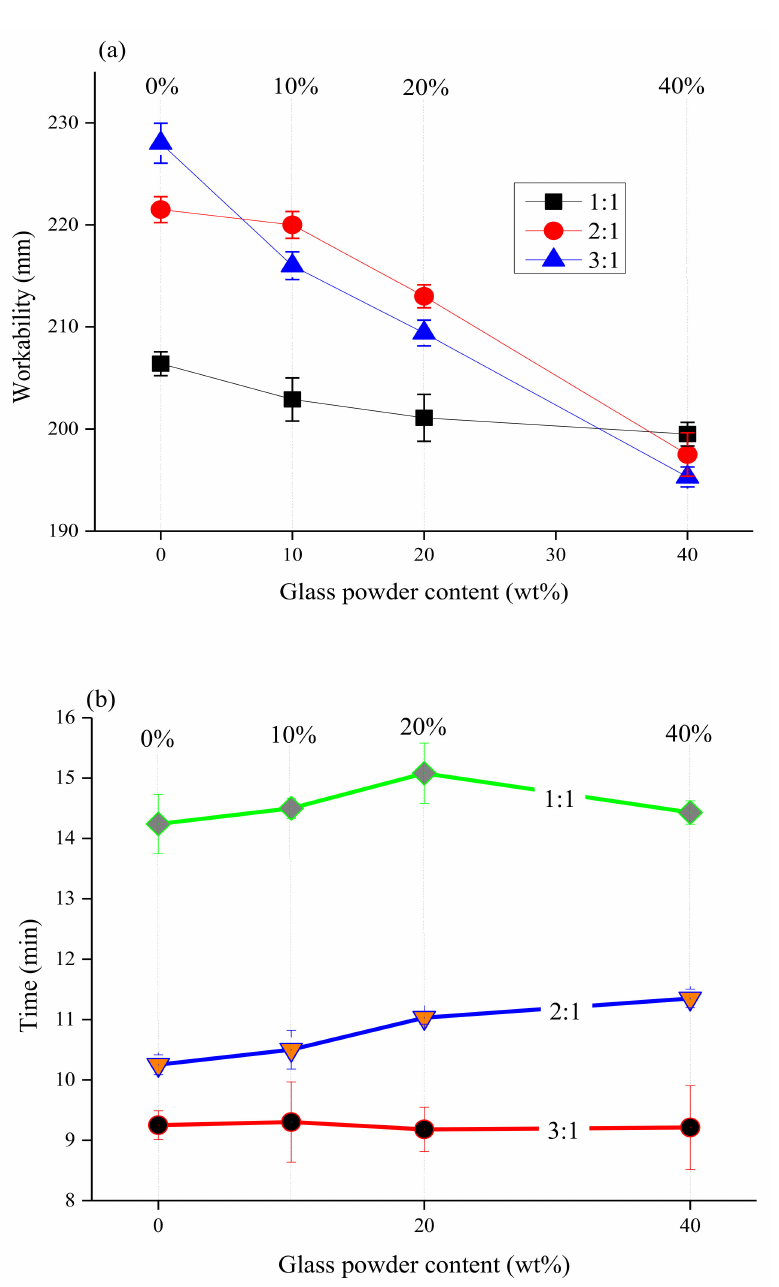
Figure 2. Setting time and workability of the MKPC specimens as a function of glass powder content (0, 10, 20, and 40 wt.%) and M/P ratio (1:1, 2:1, and 3:1), ( a ) Setting time; ( b )